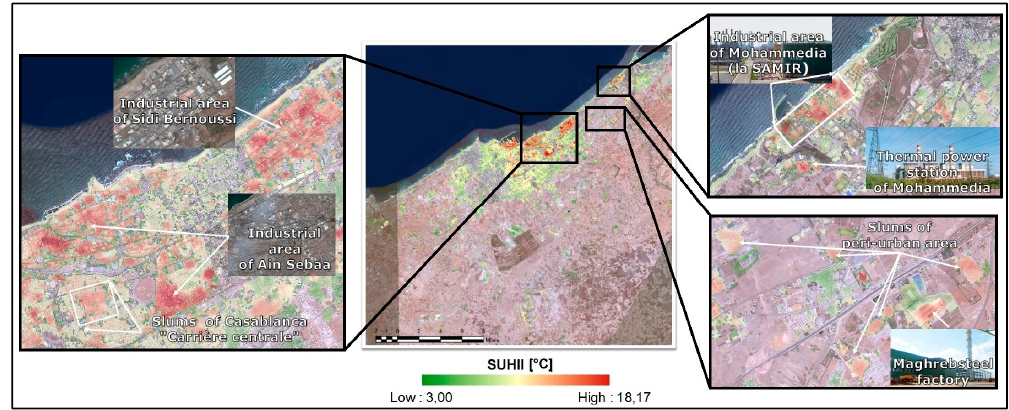
Figure 10. Spatial distribution of more intense SUHII within the Casablanca region.